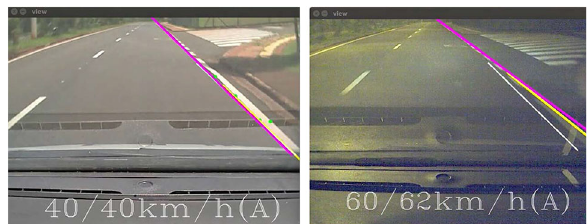
Fig. 9 Perception tests under different